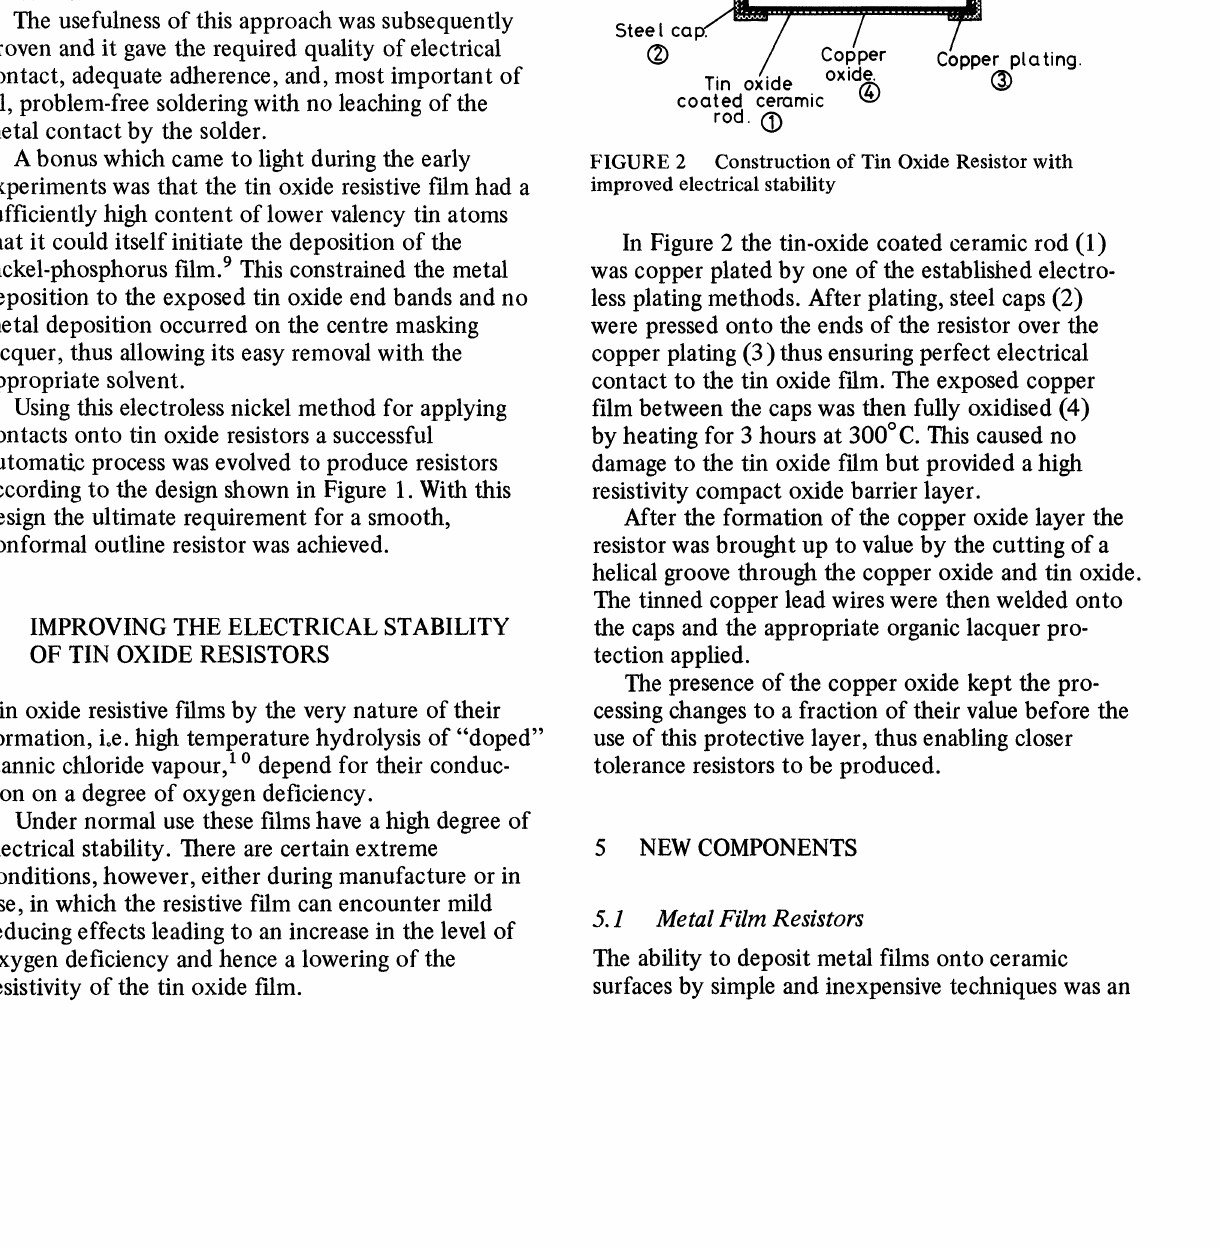
Construction of Tin Oxide Resistor with improved electrical stability In Figure 2 the tin-oxide coated ceramic rod (1) was copper plated by one of the established electro- less plating methods. After plating, steel caps